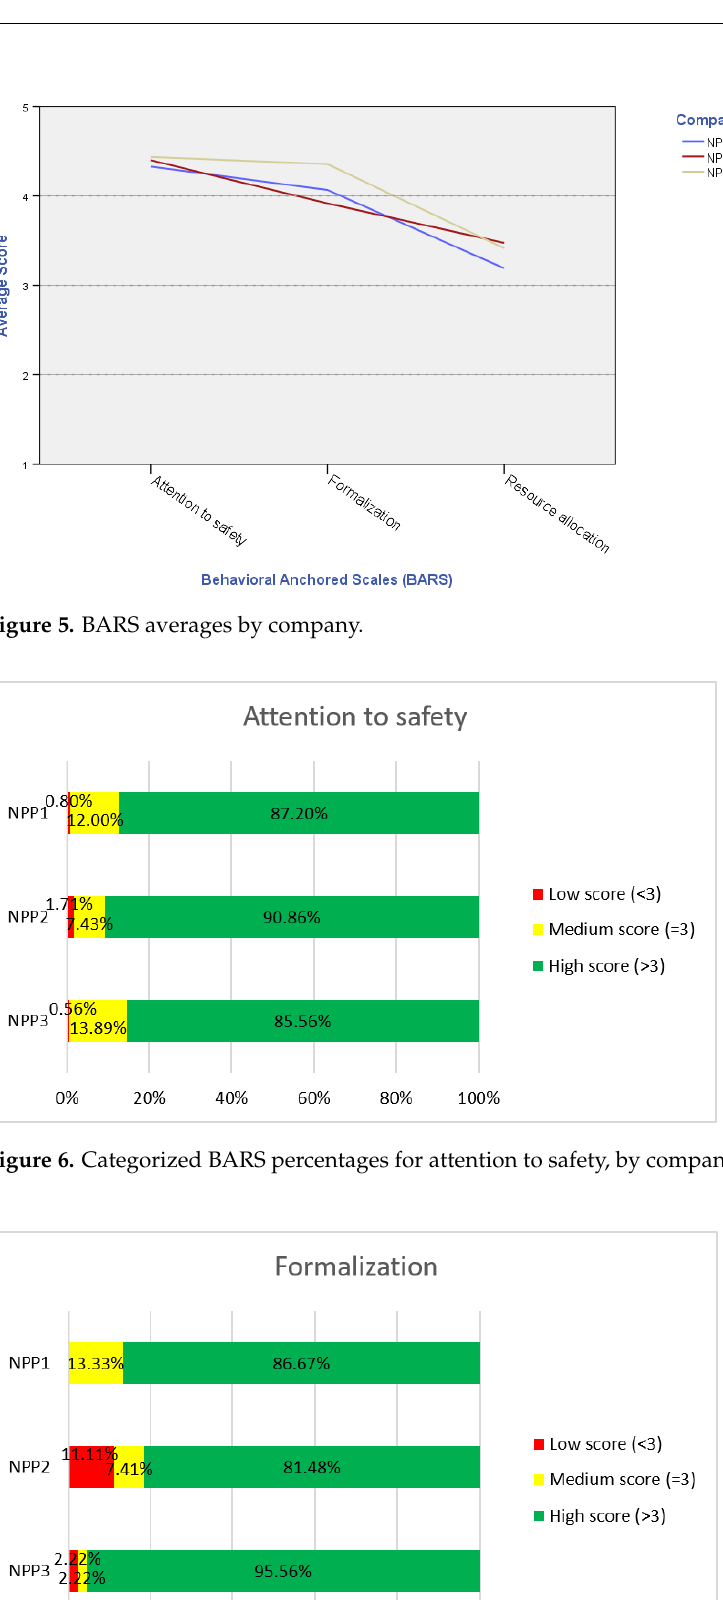
Figure 4. Scale averages by company.